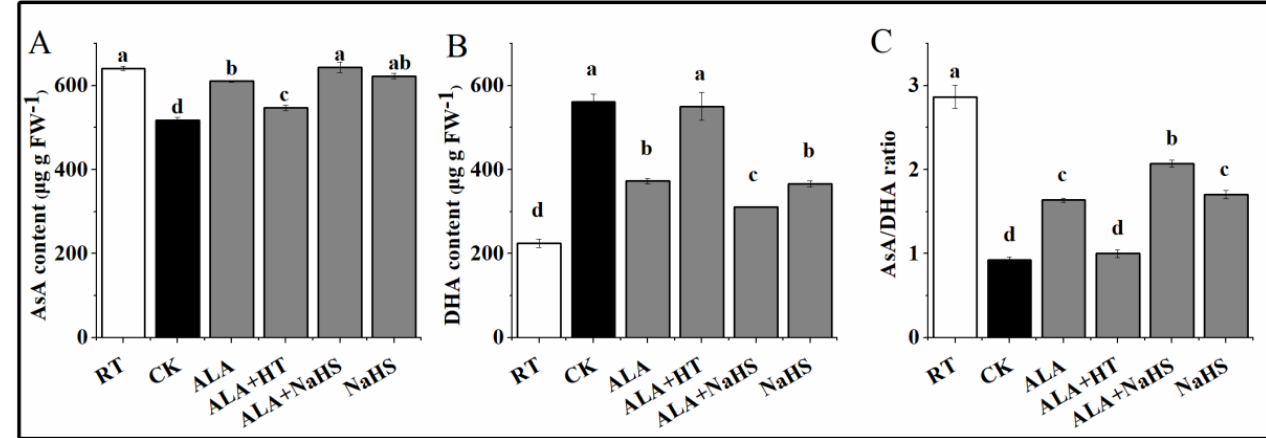
Figure 5. Effects of ALA and/or H 2 S on the contents of AsA ( A ), DHA ( B ), and AsA/DHA ratio ( C ) under chilling stress for 24 h. The error bars are the standard errors for three independent tests. Different letters show significant differences ( p < 0.05) based on Duncan’s test.